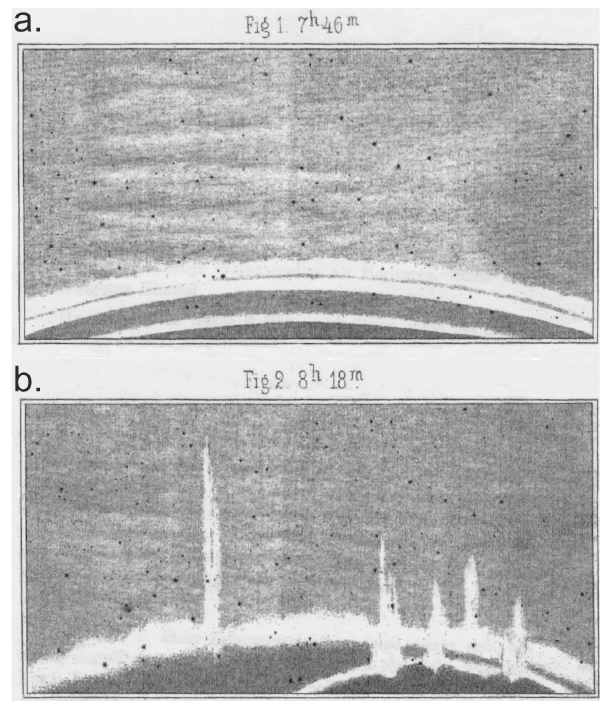
Figure 1. Sophus Tromholt (from Tromholt, 1889). (the dark space below the arc) or to the midpoint between the foot points of fully extended arcs. For this day he reported 11 directions between extremes of 9 ◦ and 27 ◦ west of north with an average value of 18 ◦ . He notes in the article that the local magnetic declination is 15 ◦ .